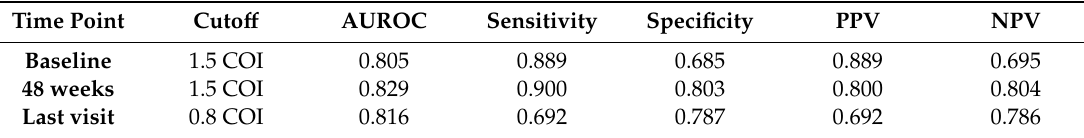
Figure 3. Receiver operator characteristics curves for prediction of hepatocellular carcinoma at different time points. ( a ) Baseline serum Mac ‐ 2 ‐ binding protein glycosylation isomer (M2BPGi) levels ( b ) serum M2BPGi levels at 48 weeks ( c ) serum M2BPGi levels at the time of last visit. Table 3. Performance of serum M2BPGi levels for predicting HCC. Table 3. Performance of serum M2BPGi levels for predicting HCC.